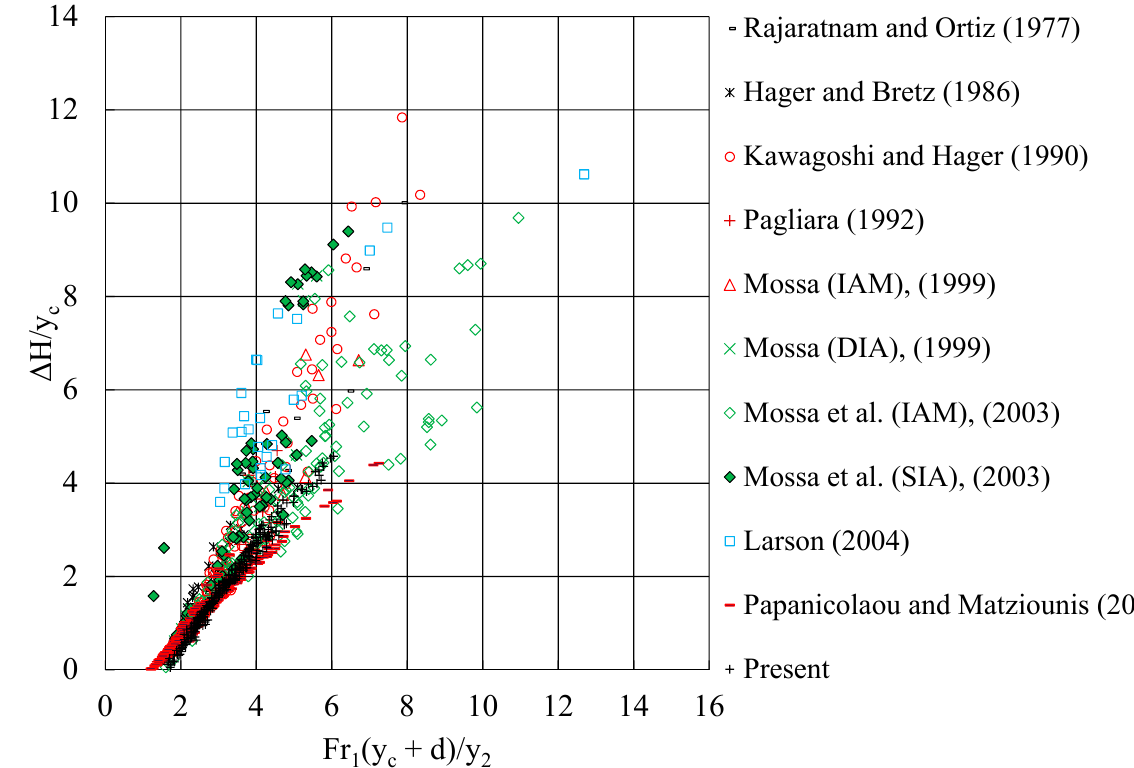
Figure 19. Dimensionless energy loss ∆ H/y c as a function of Fr 1 (y c + d)/y 2 for all types of jumps [4,6,7,9,12,13,19,22,23].